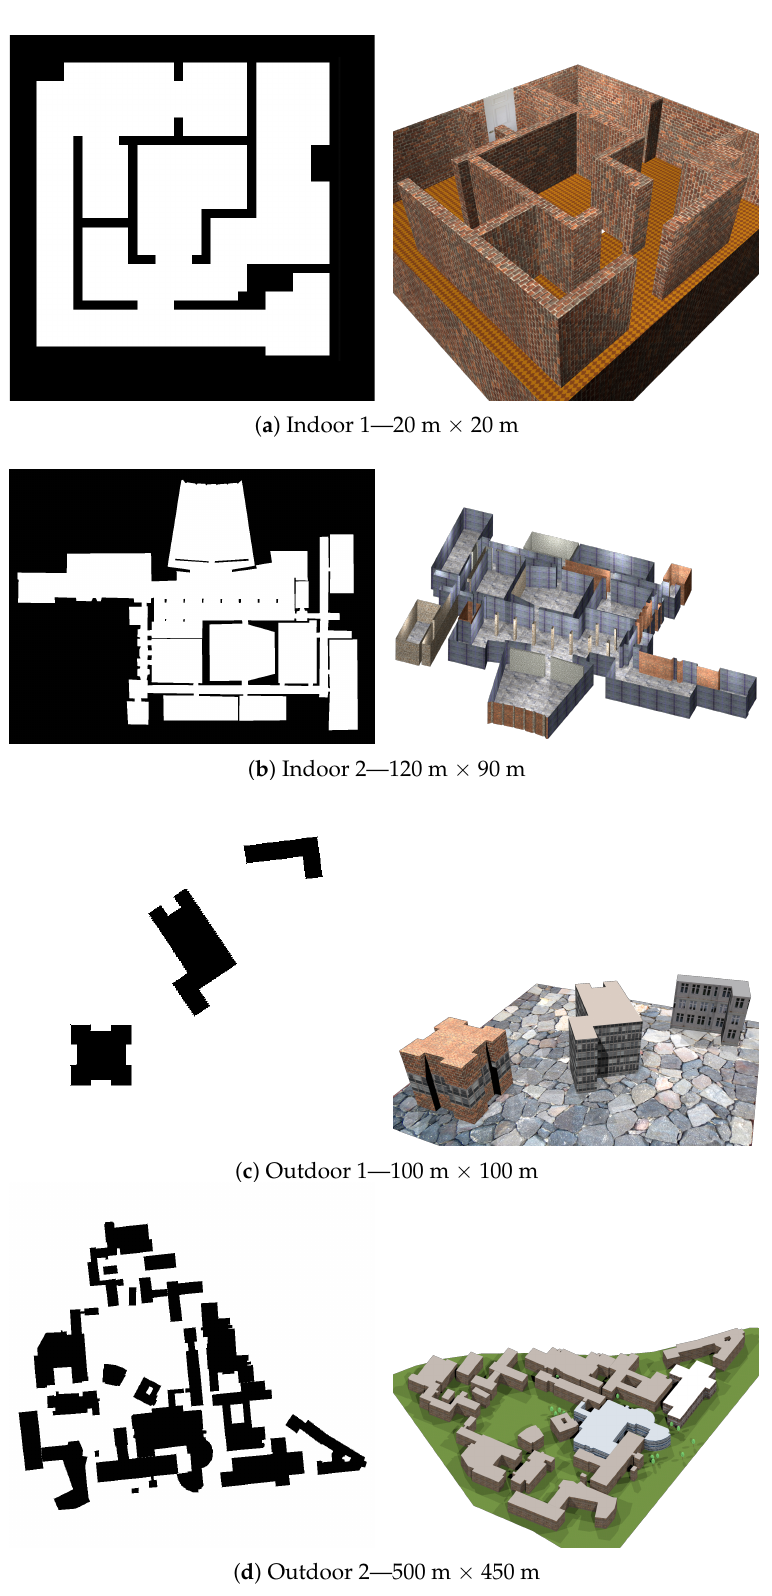
Figure 9. Known maps ( left ) and renderings ( right ) of simulation environments with their rough sizes. These occupancy maps show occupied (black) and free (white)